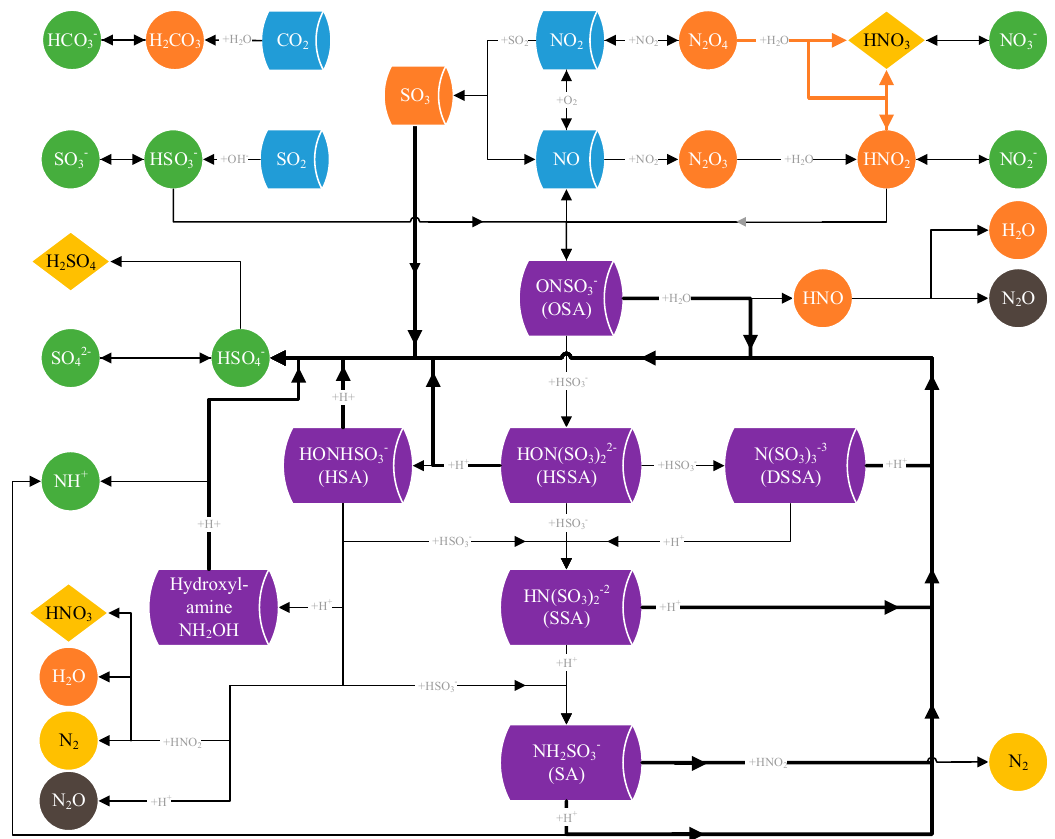
Figure 3. Reaction mechanism involving N-S complex species.